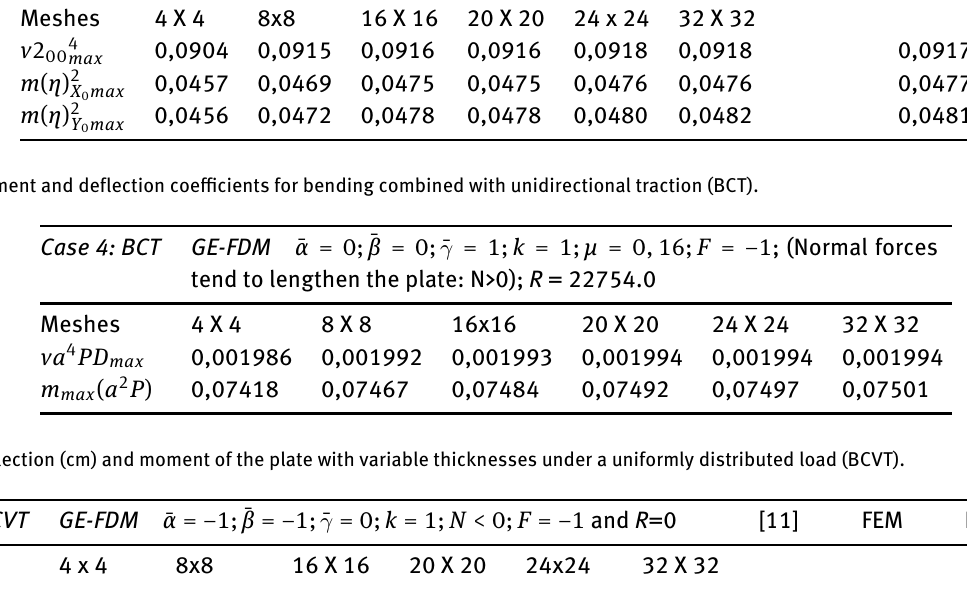
Table 4: Maximum moment and deflection coeflcients for simple bending (SB). Case3: SB